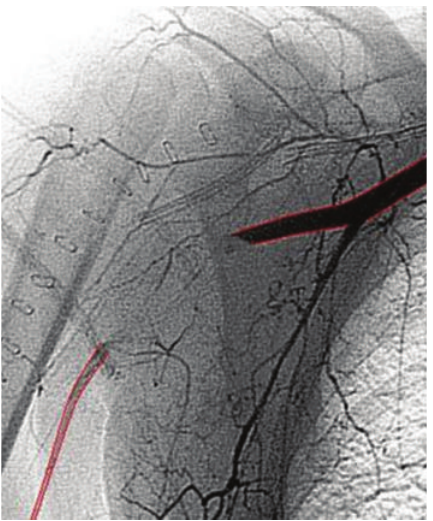
Figure 8: Collateral filling of the brachial artery.